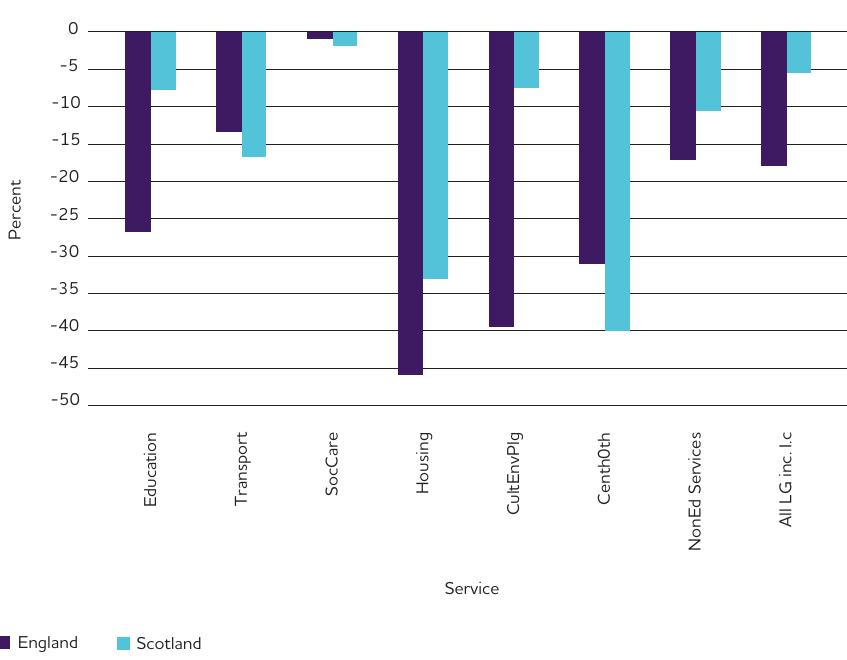
Figure 10: Real Spending Changes in Local Services, England and Scotland,